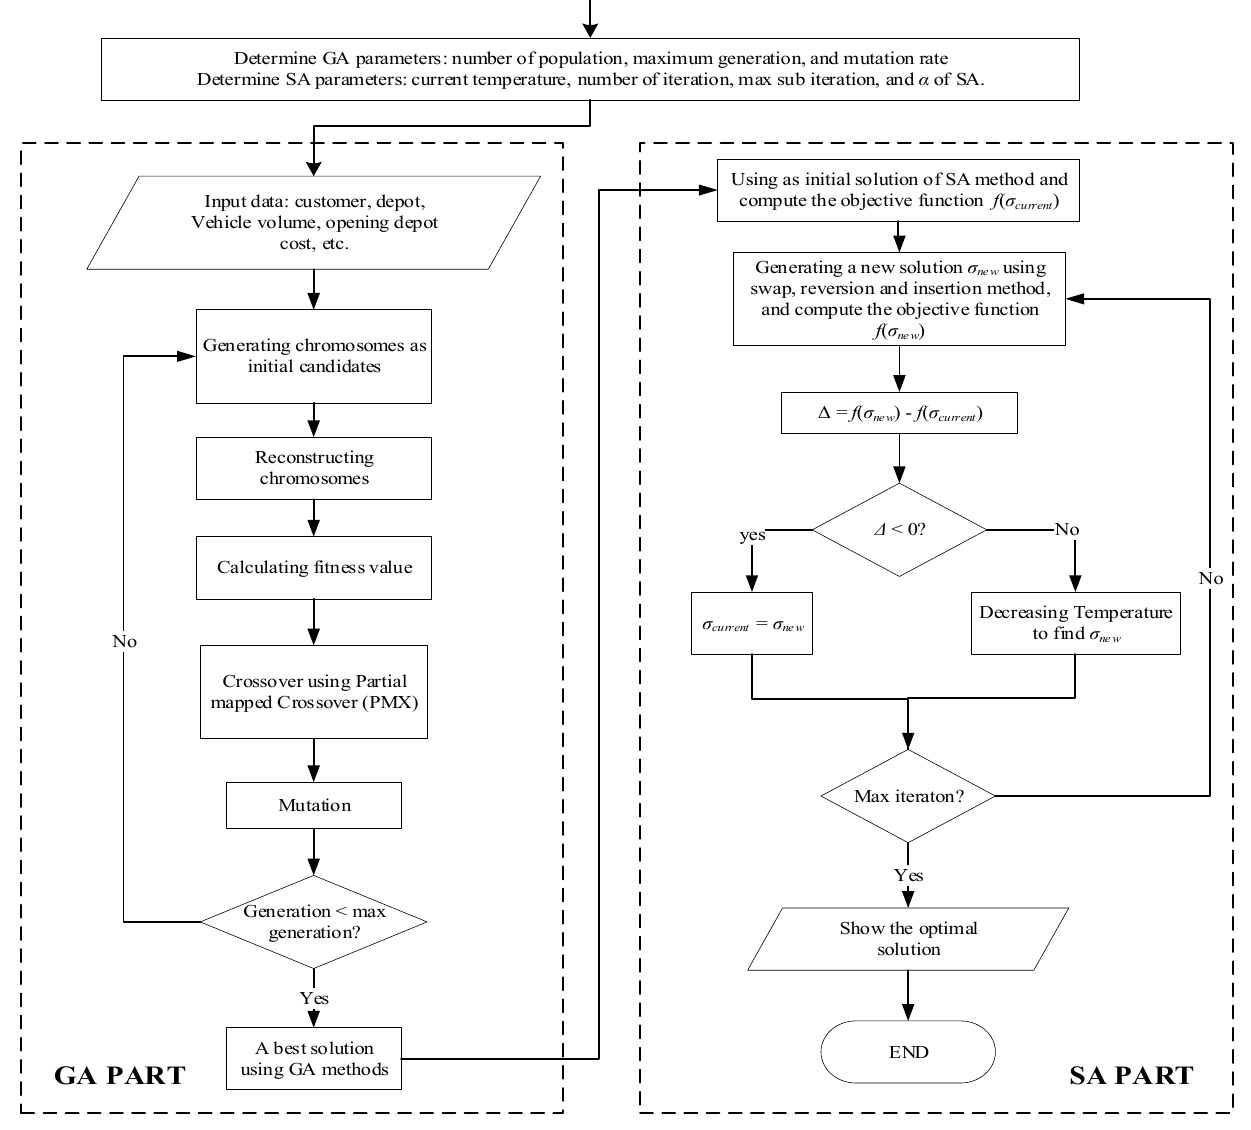
Figure 2. The hybrid mechanism for GASA.